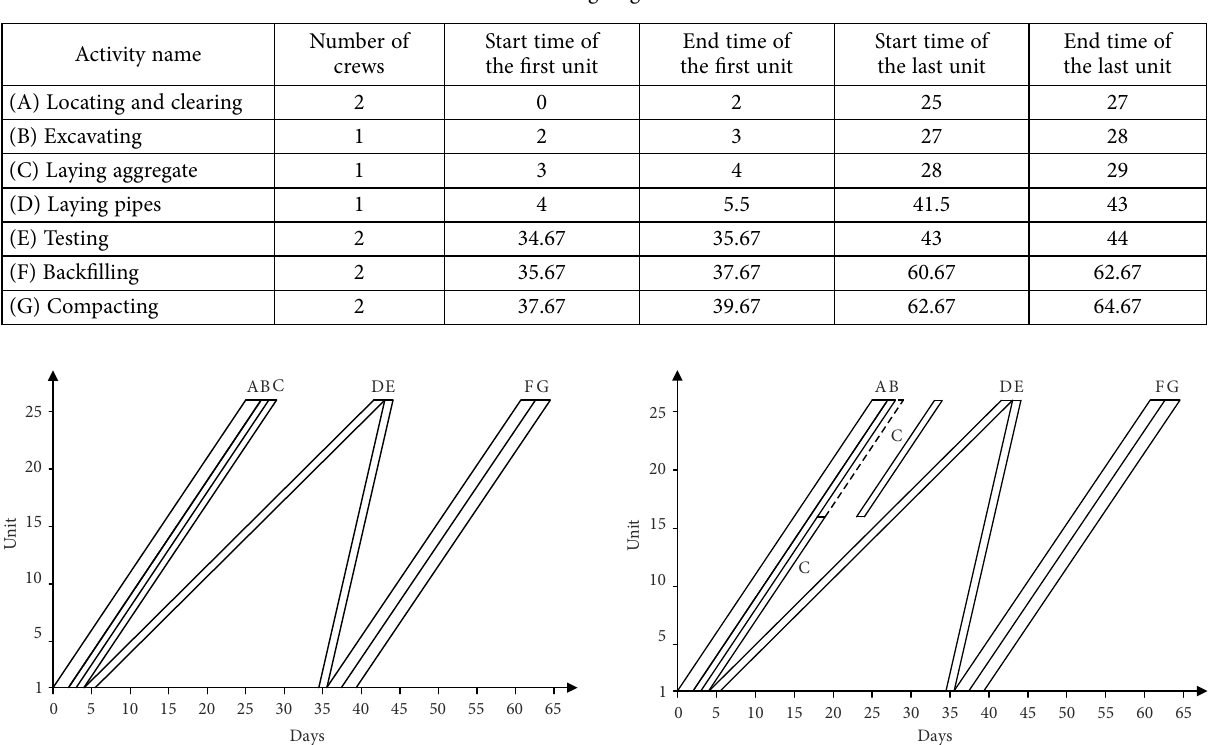
Table 2. First stage algorithm results